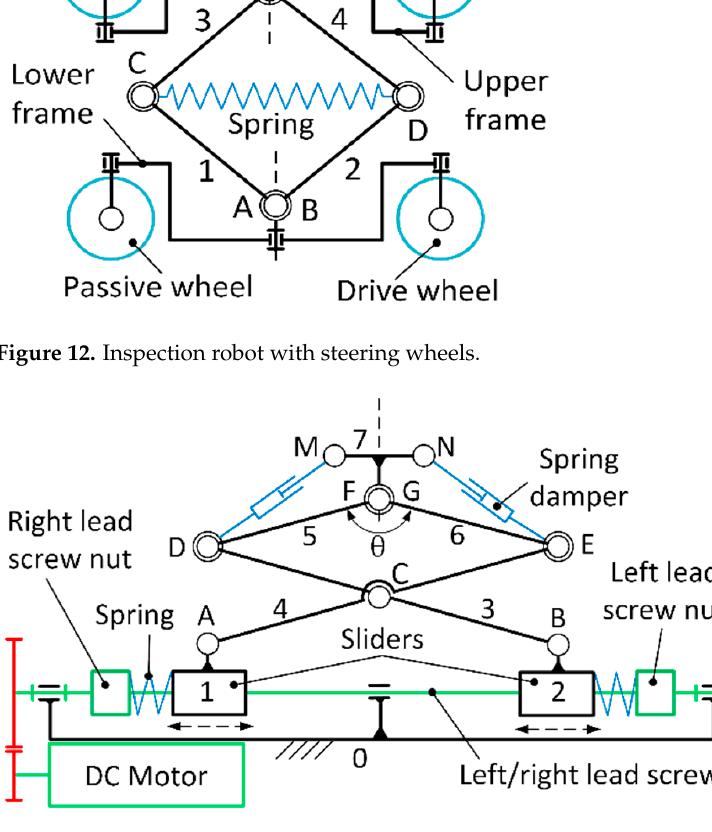
Figure 13. Active adapting mechanism based on a pantograph linkage with two sliders.